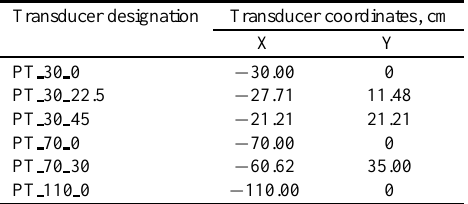
Table 2 Coordinates of the pressure transducers located in air. The origin of the coordinate system is located along the line of symmetry at the sand/air